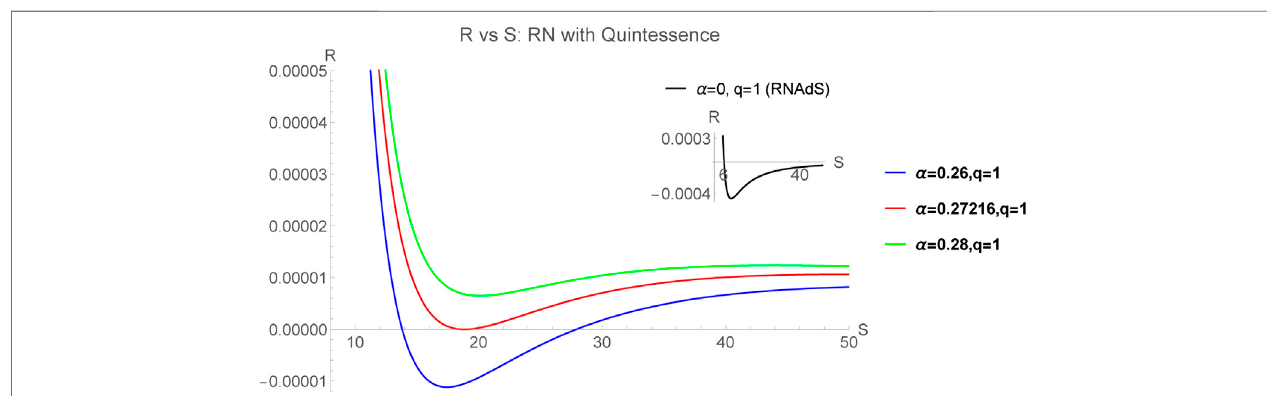
Frontiers in Physics |